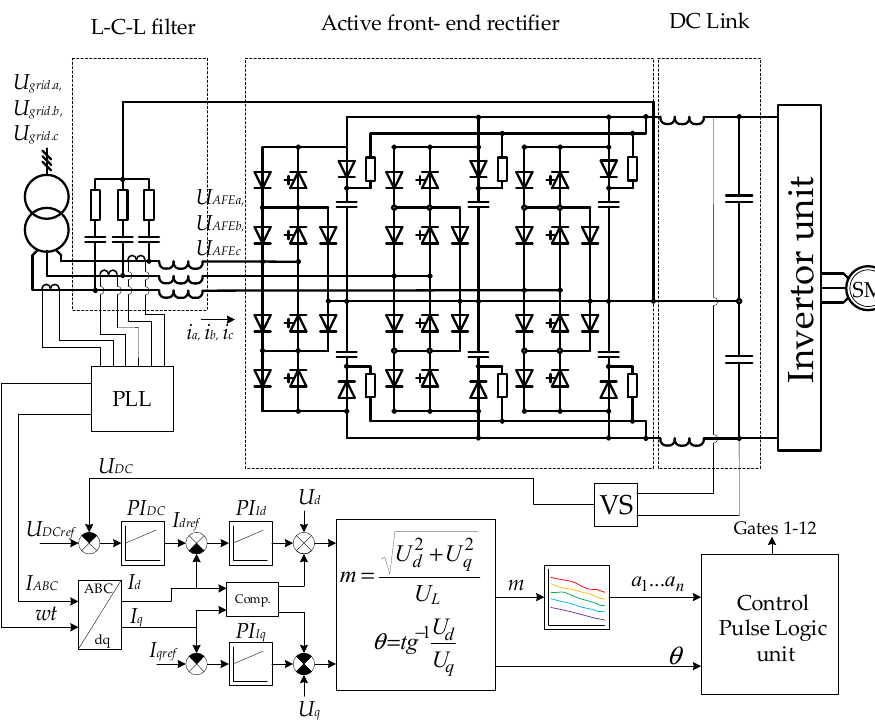
Figure 5. The function diagram of the AFE control system.